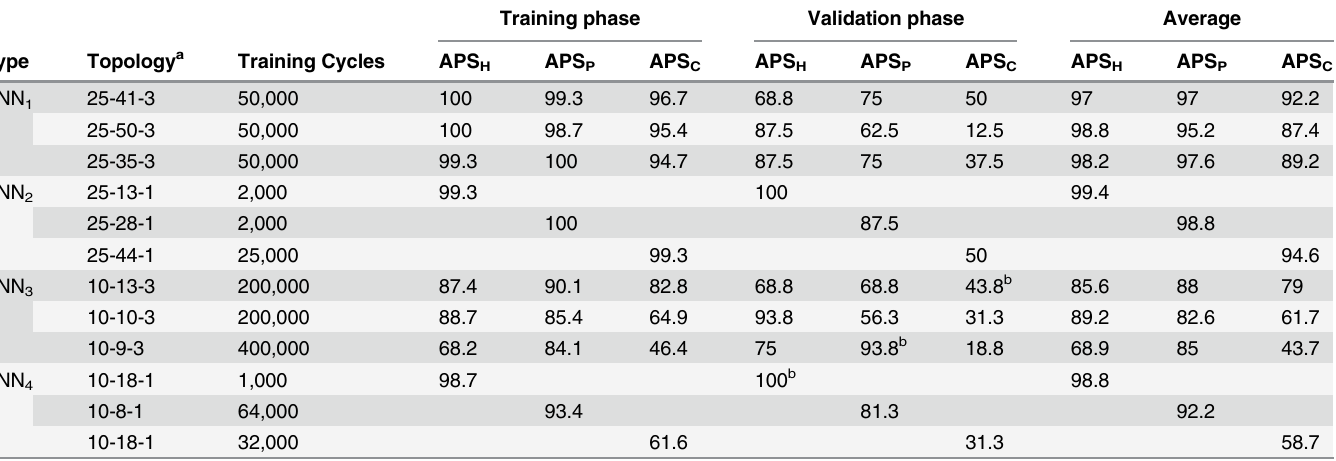
Table 2. Average Percentage of Success (APS) for the training, validation and average phases (mean APPS for training and validation phase to- gether) considering all variables for harvest date (APS H ), production type (APS P ) and the tomato cultivar (APS C ) for models with 25 input variables (ANN 1 and ANN 2 ) and models with 10 input variables (ANN 3 and ANN 4 ).